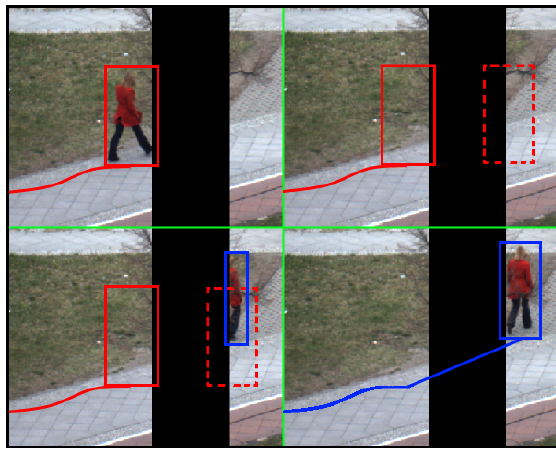
Figure 3: Top left: Tracked person (red) approaching occlusion. Top right: Person hidden by occlusion, tracker searches for per- son at the predicted position (red dashed). Bottom left: Person emerges partially at an unpredicted position. A new tracked per- son is created (blue). Person emerges fully, is matched with both red and blue tracked persons. The data is fused and stored for the next frames.